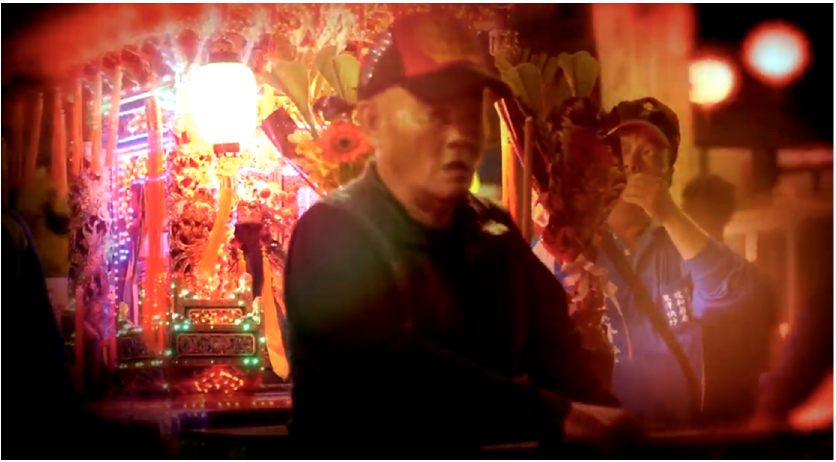
Figure 7. A townsperson carries an elaborate palanquin with effigy during the Wang Yeh boat burning festival in Donggang, Taiwan. Image courtesy of Ye Mimi.